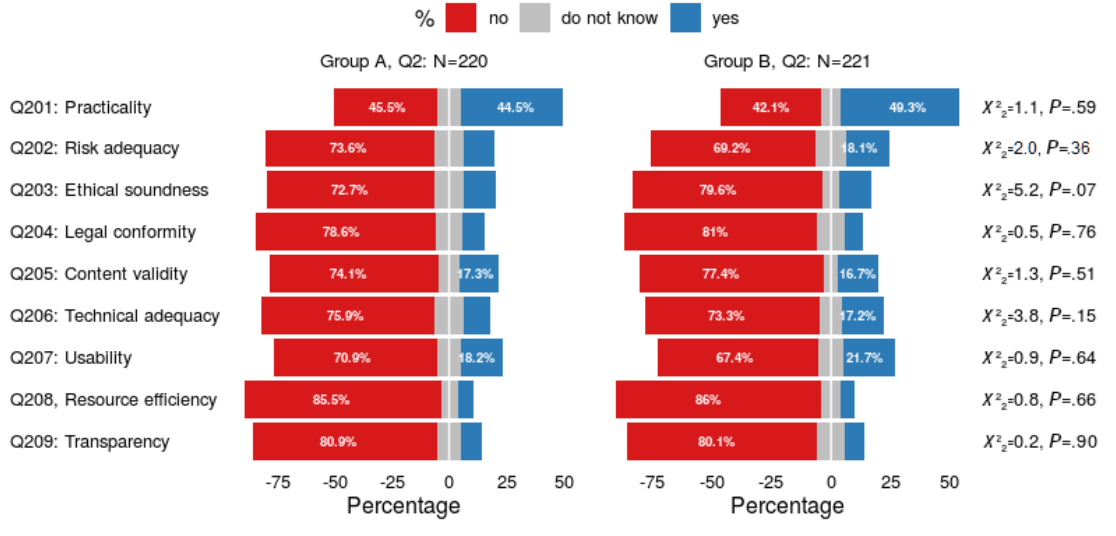
Figure 3. Graphical representation of the participants’assessments of whether the provided app descriptions contain sufficient information with respect to the nine quality principles, stratified by the randomly assigned groups: group A (test) and group B (validation). Results for the corresponding chi-square tests are also shown. Q2: questionnaire